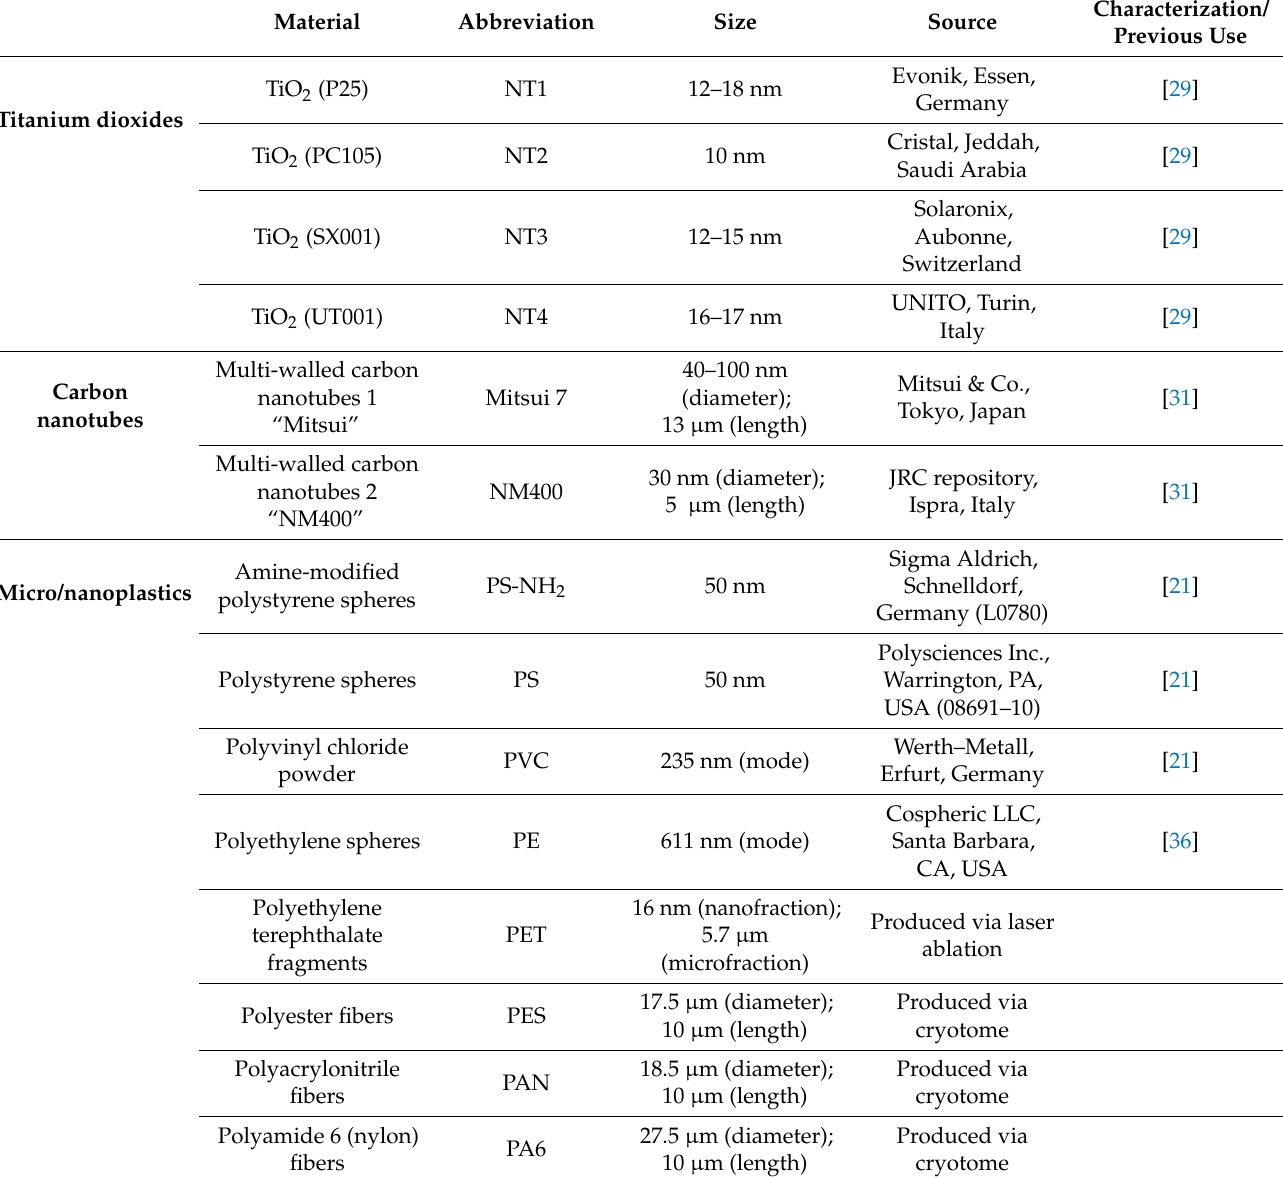
Table 1. TiO 2 samples, carbon nanotubes, and MNPs used for